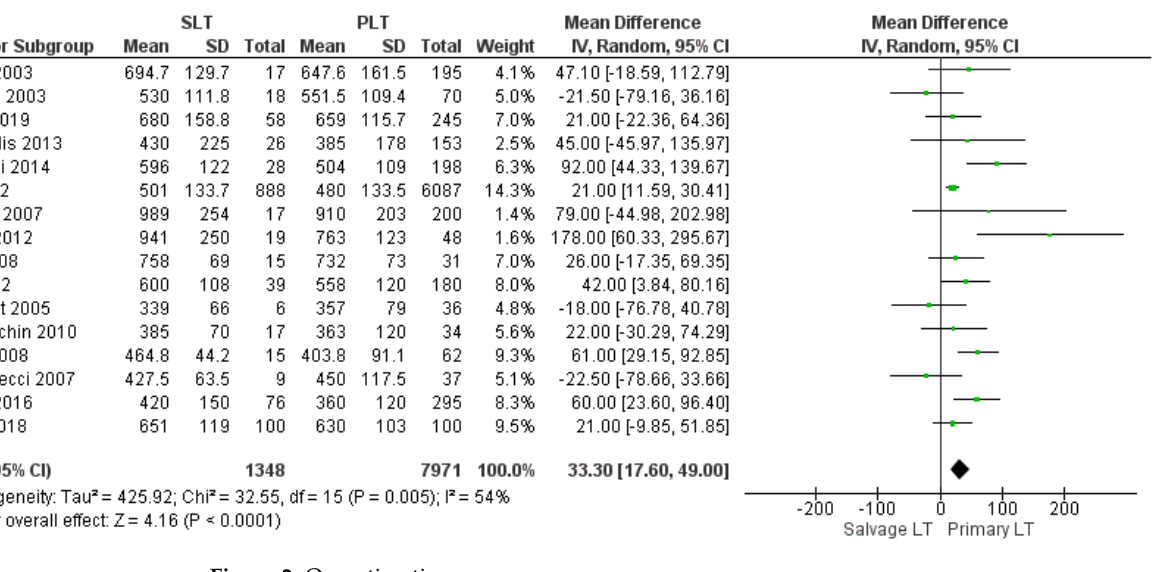
Figure n.4 - Intraoperative Red Blood Cell (RBC) transfusion